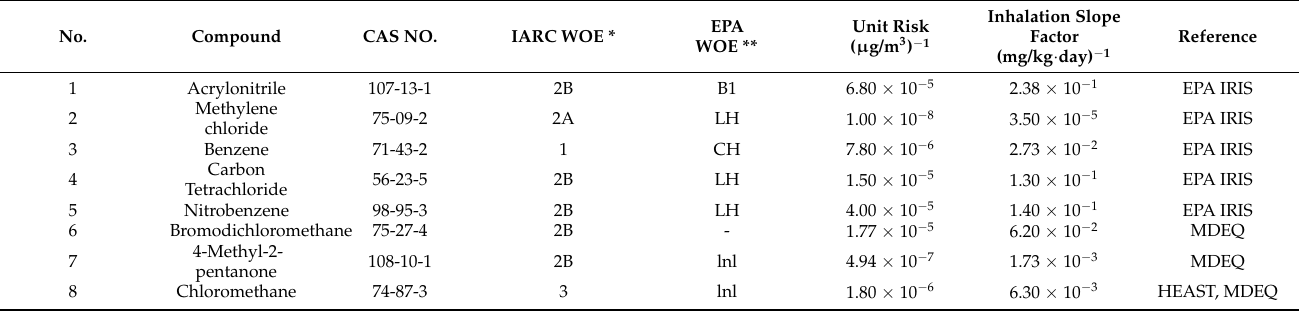
Table 1. Dose–response data of toxic carcinogenic VOCs.